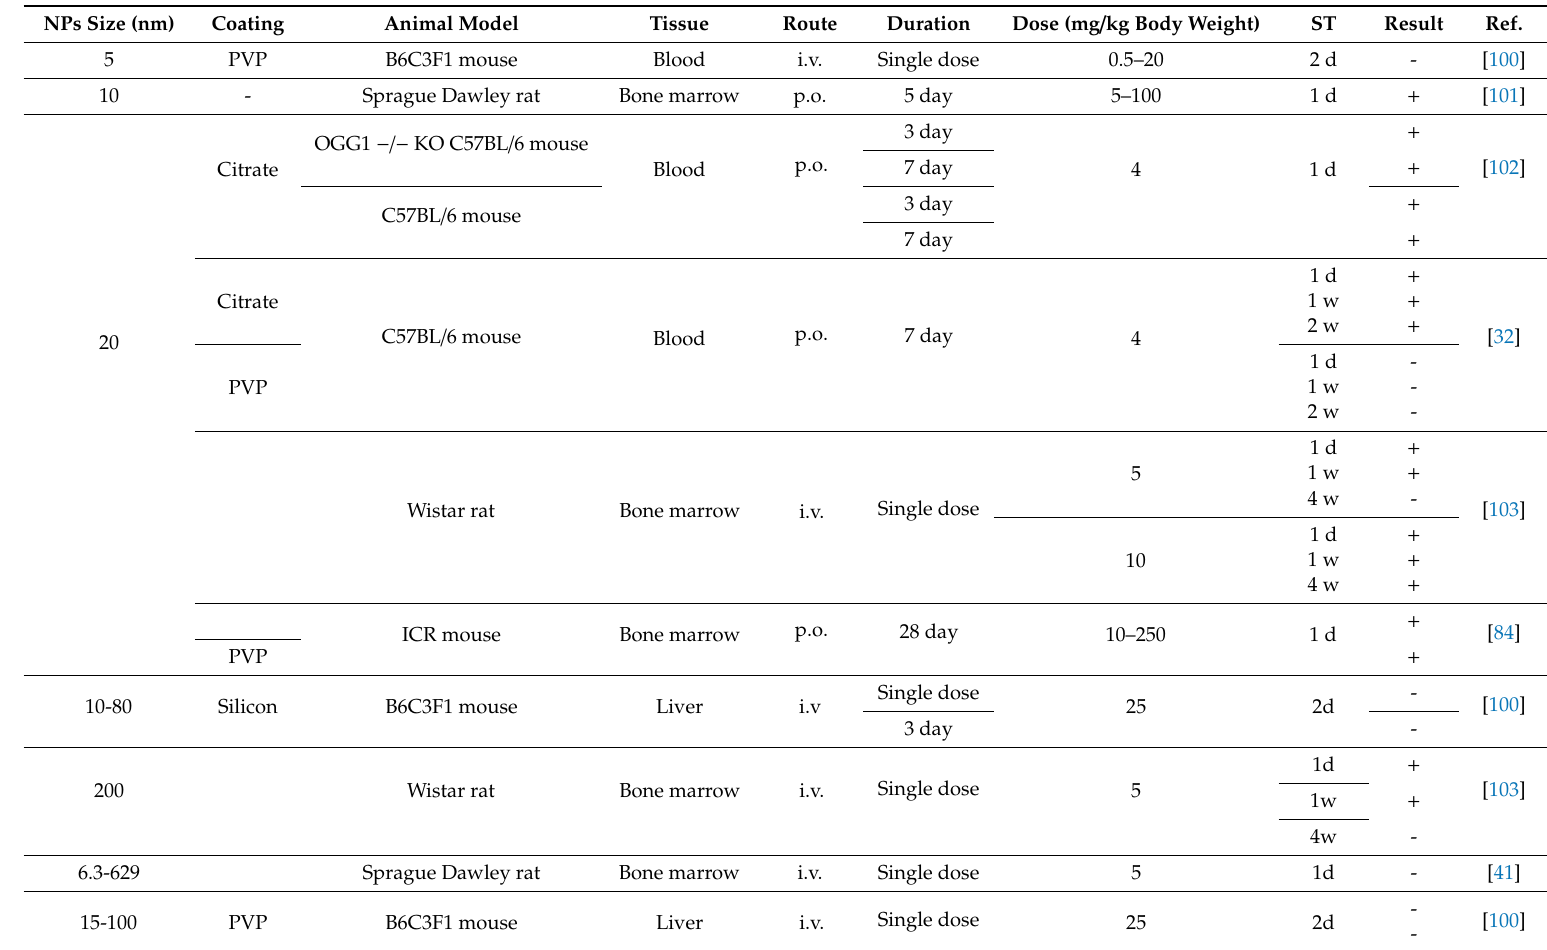
Table 4. In vivo micronucleus assay